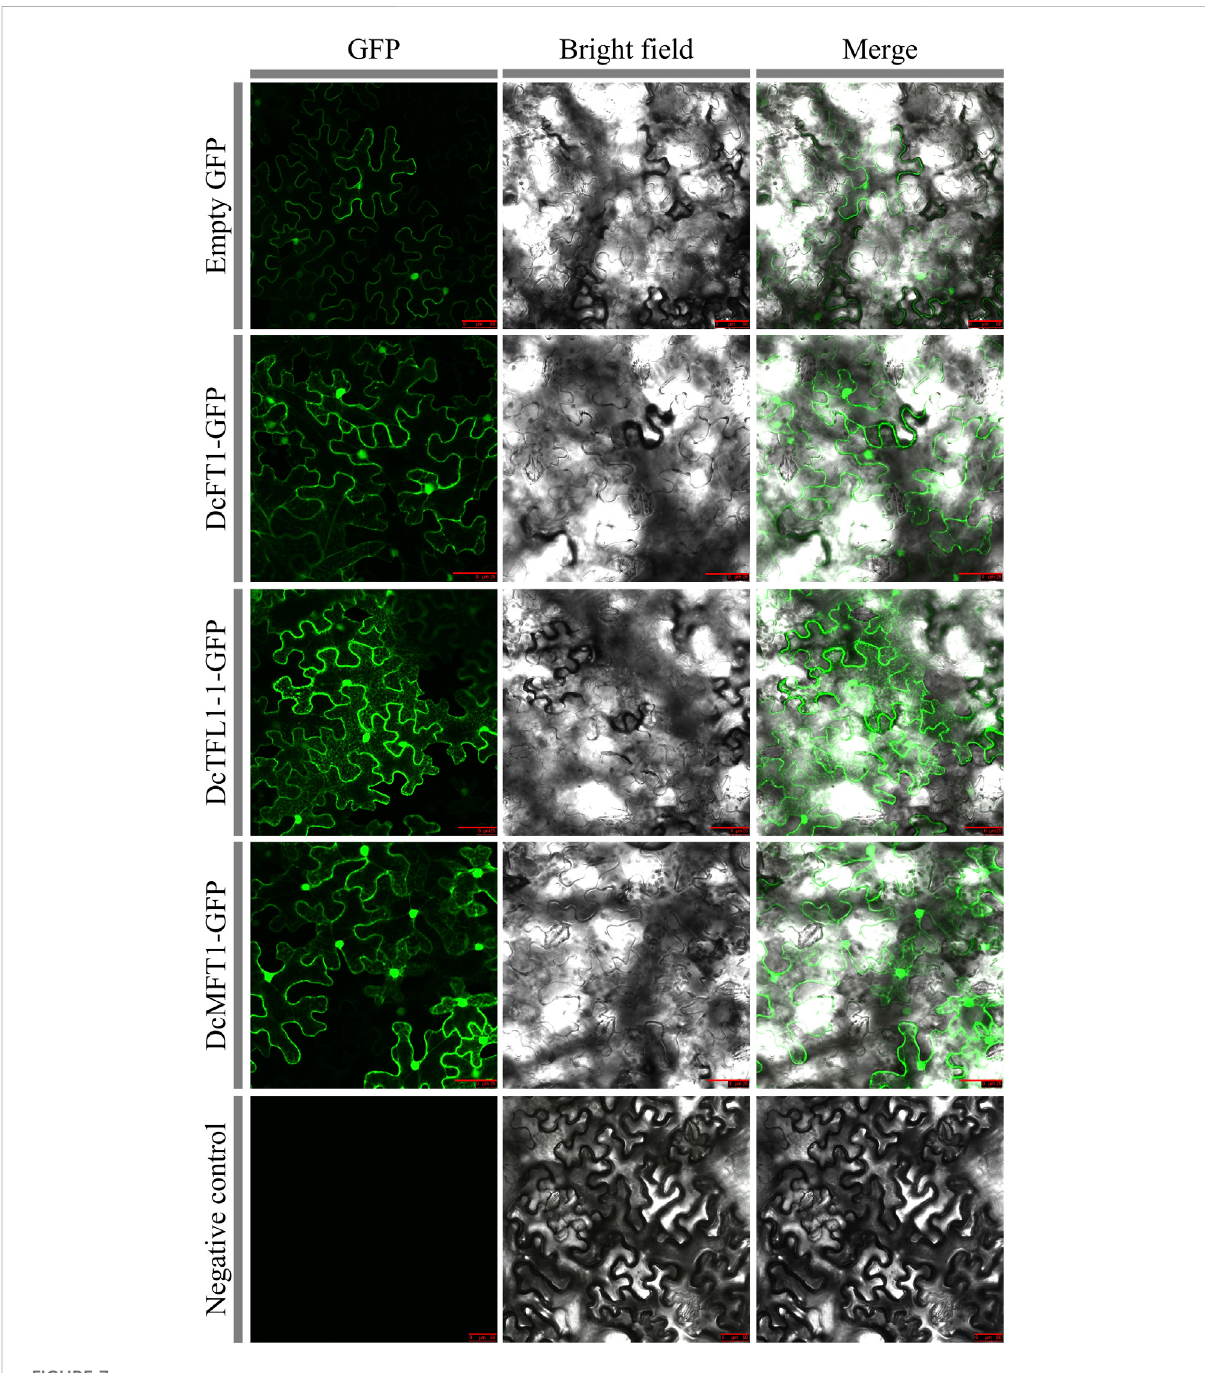
FIGURE 7 Transient expression of three carrot PEBP proteins in tobacco cells. Bars = 50 μ